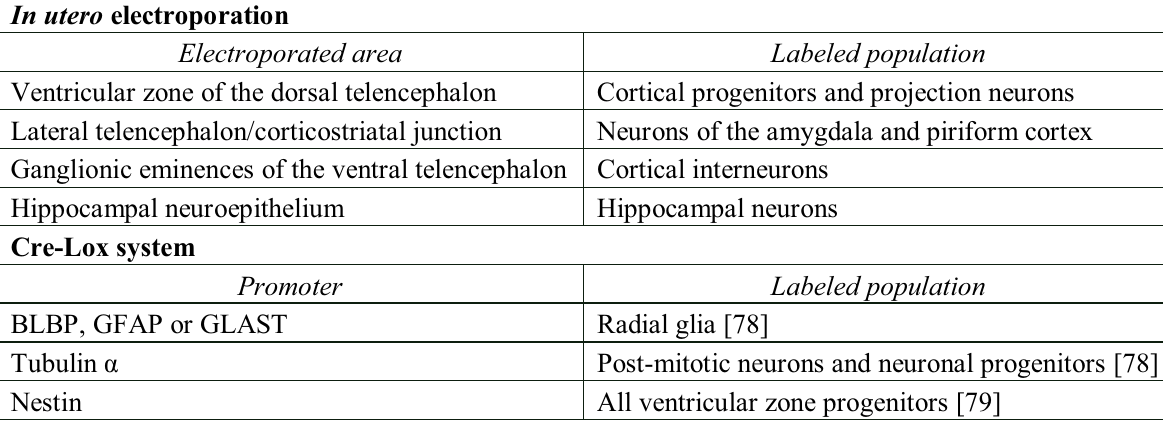
Table 3. Common methods to target different cortical